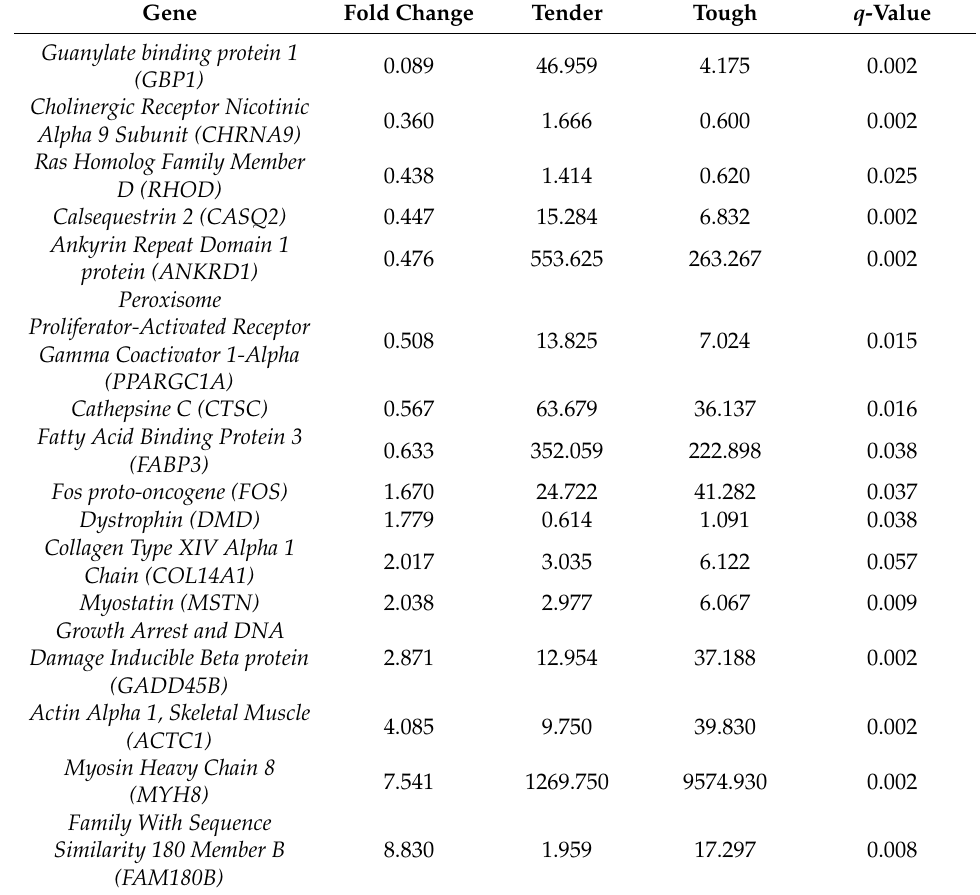
Table 1. Fold change, mean expression value in the Tender and Tough groups, q-value and with p-value < 0.05 , corresponding to the most relevant di ff erentially expressed genes. Gene Fold Change Tender Tough q